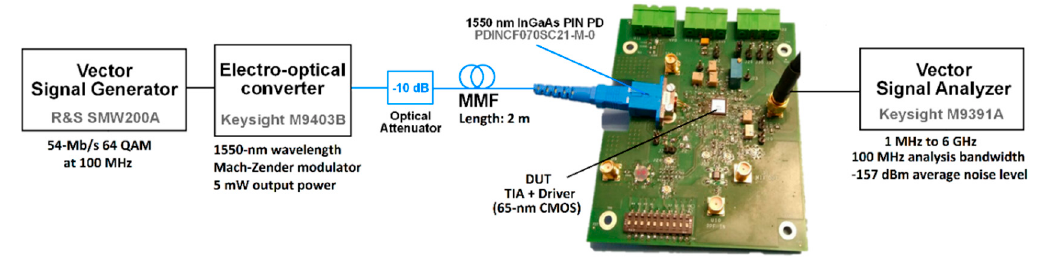
Figure 8. Schematic diagram of the experimental set-up for optical data transmission.